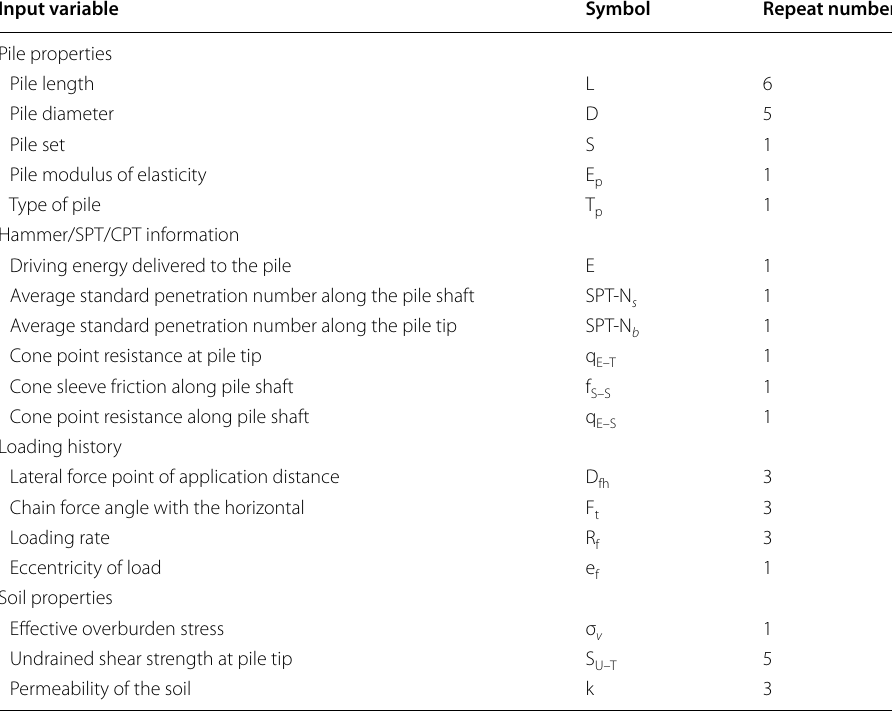
Table 7 GP input